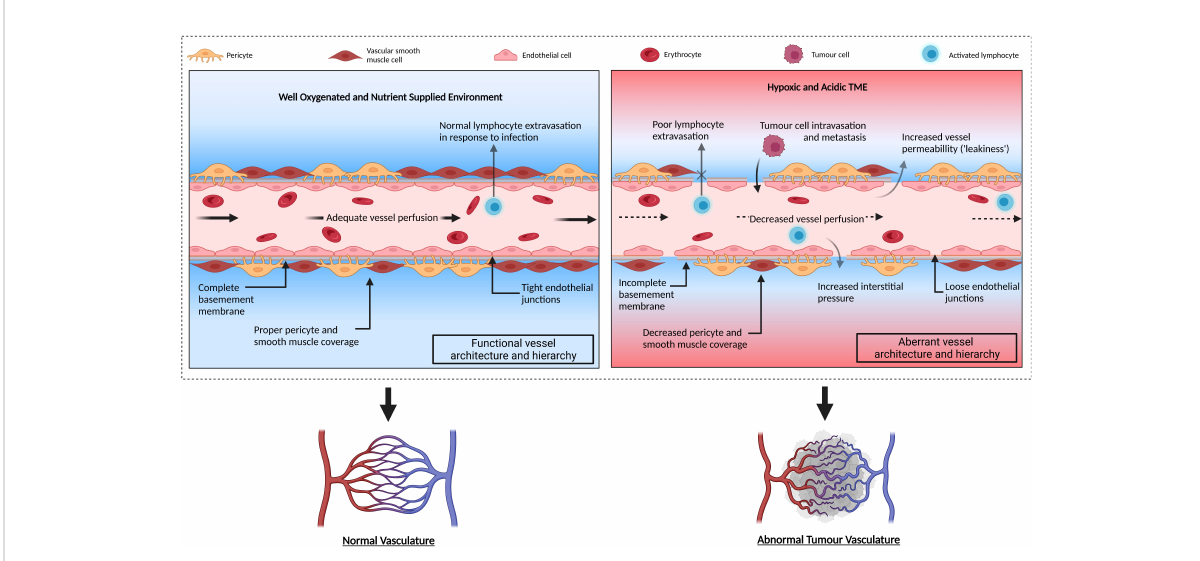
FIGURE 2 Schematic illustration of normal functioning vasculature compared to aberrant tumour vasculature. Normal vessels demonstrate correct vascular hierarchy composed of arteries, arterioles, capillaries, venules, and veins. The vasculature is well-organised with endothelial cells exhibiting complete basement membrane and adequate mural cell (pericyte and vascular smooth muscle cell) coverage. The vessels are well perfused allowing suf fi cient oxygen supply and metabolic waste removal from the surrounding tissue. Conversely, the tumour vasculature exhibits reduced effector T cell extravasation into tumour parenchyma and displays a lack of mural cell coverage which destabilises the vessel. The relaxed endothelial tight junctions and incomplete basement membrane coverage allows fl uid to escape into the surrounding area, increasing the surrounding interstitial pressure and reducing vessel perfusion. This prevents adequate oxygen supply to the tissues and ineffectively removes metabolic waste. Consequently, the surrounding area becomes hypoxic and acidic. Original fi gure created with